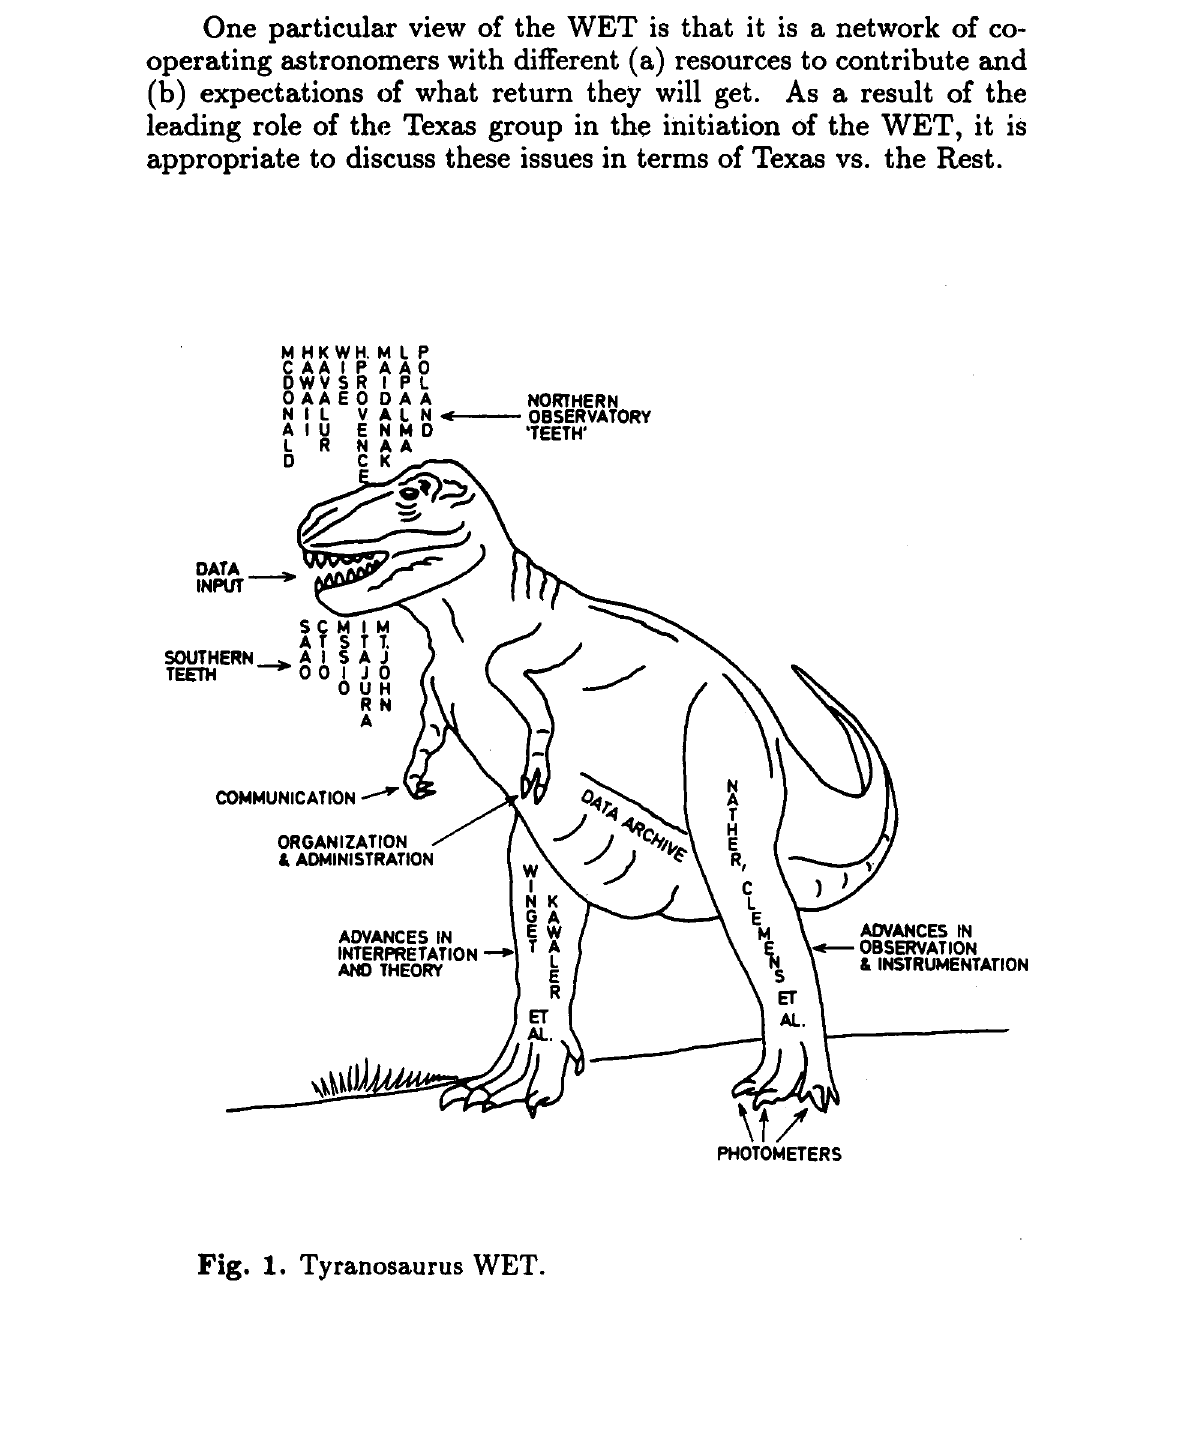
Fig. 1. Tyranosaurus